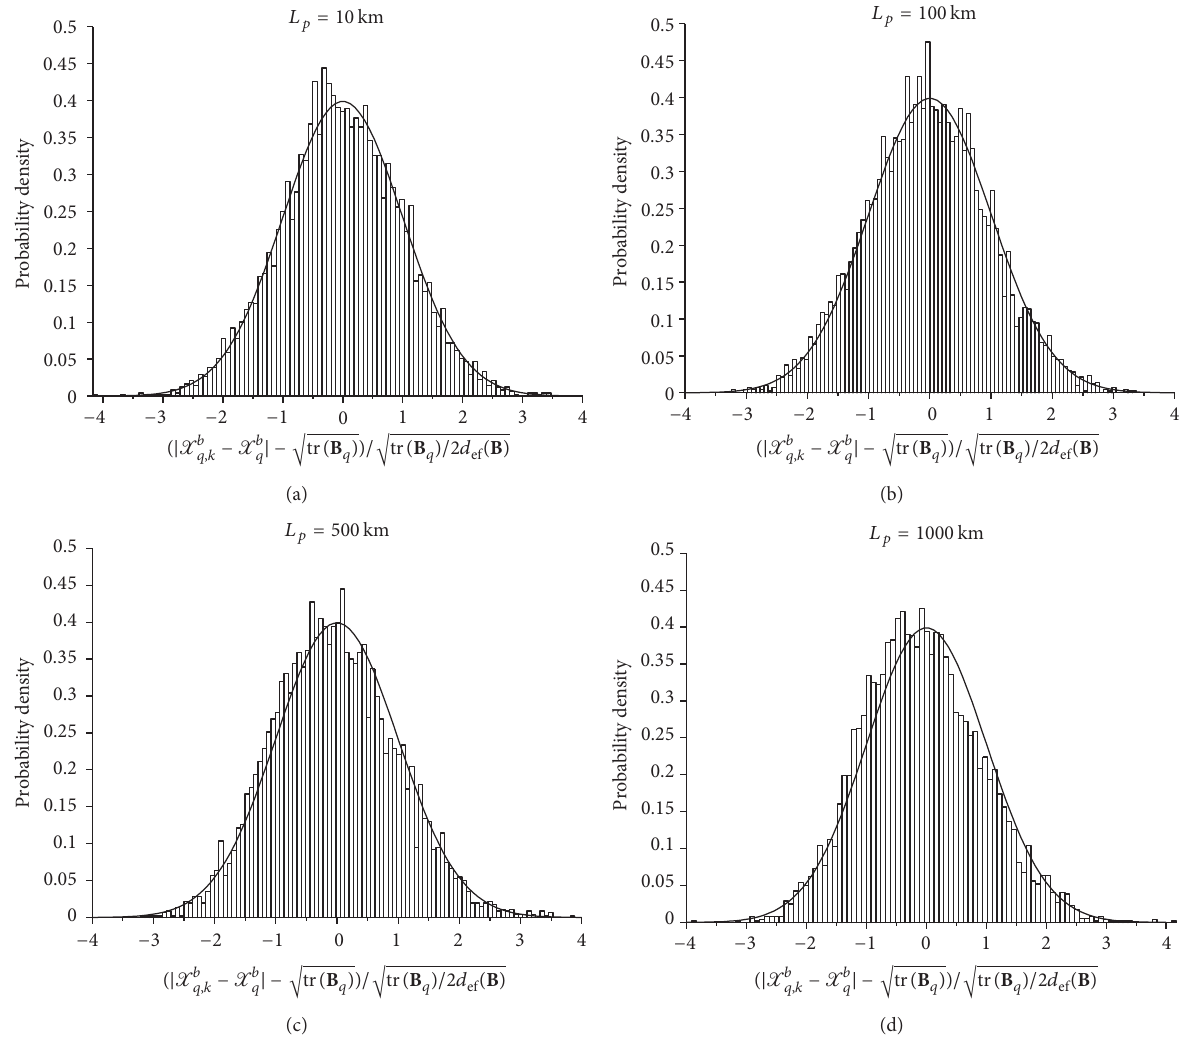
Figure 5: Histogram of distribution of the normalized distance (| X 𝑏 𝑞,𝑘 − X 𝑏 𝑞 |−√ tr ( B 𝑞 ))/√ tr ( B 𝑞 )/2𝑑 ef ( B ) normalized and compared with the theoretical asymptotic Gaussian law N (0,1) (solid line), estimated from an ensemble of 𝑁 = 6400 samples and represented for the different length-scale values: (a) 𝐿 𝑝 = 10 km, (b) 𝐿 𝑝 = 100 km, (c) 𝐿 𝑝 = 500 km, and (d) 𝐿 𝑝 = 1000 km, for the dimension set to 𝑛 = 1000